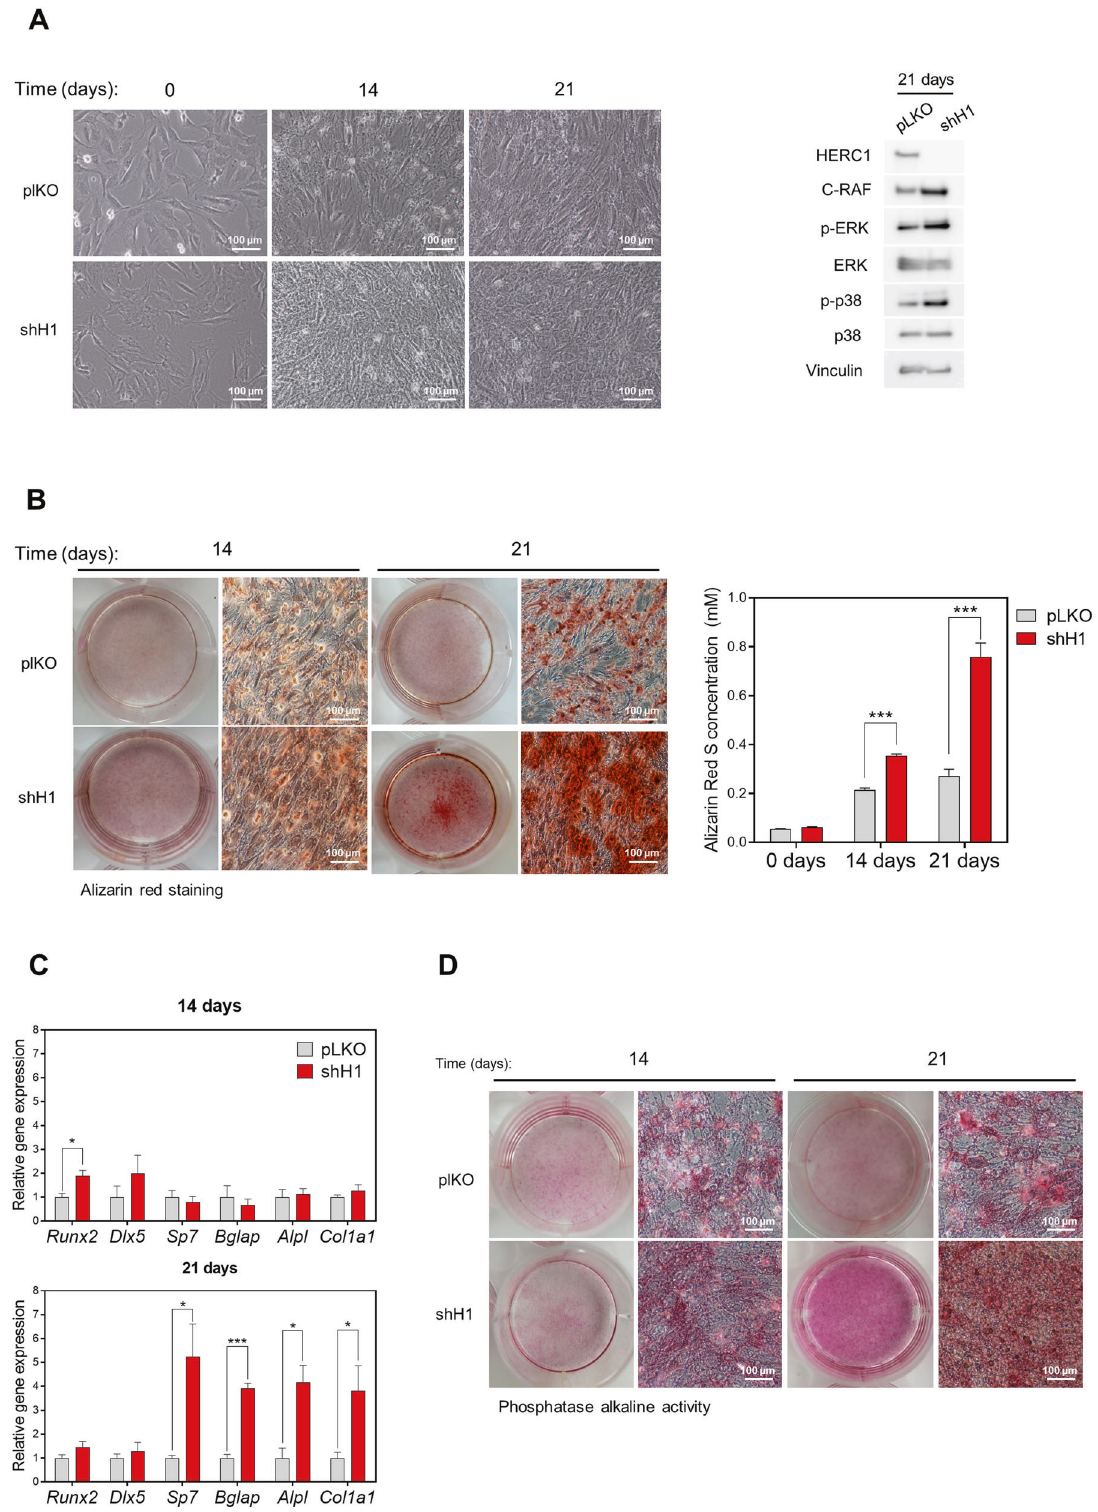
Fig. 1 HERC1 regulates the osteoblastic differentiation. Bone marrow derived MSCs were infected with lentiviral particles carrying either the empty plKO vector as a negative control (plKO) or an shRNA against HERC1 (shH1) and were further treated with an osteoblastic differentiation medium. A Representative images of differentiation process at 0, 14, and 21 days. Lysates were analyzed by immunoblotting, using speci fi c antibodies against the indicated proteins. B Alizarin Red staining. Representative images were acquired by optical microscopy at the times indicated. Quanti fi cation is shown ( n = 5). C Osteoblastic gene expression of MSCs undergoing differentiation at the times indicated. The mRNA expression levels were measured by RT-qPCR and normalized to Tbp expression ( n = 4). D Cells were fi xed and stained for alkaline phosphatase activity. Representative images are shown. Data are expressed as mean ± SEM. Signi fi cant differences: * p < 0.05; ** p < 0.01; *** p < 0.001.